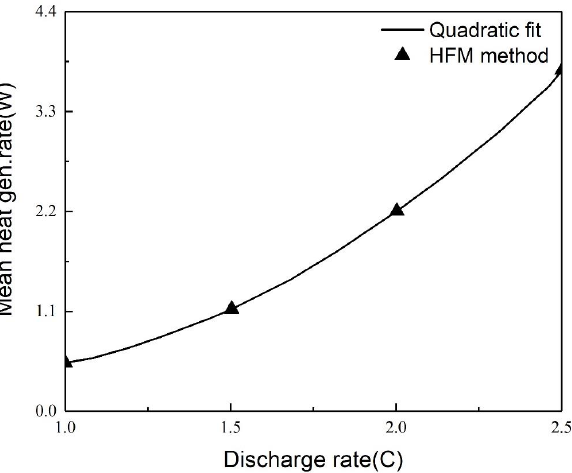
Figure 1. The average heating rate of 21700 batteries at different discharge rates. (Data from Lei et al.